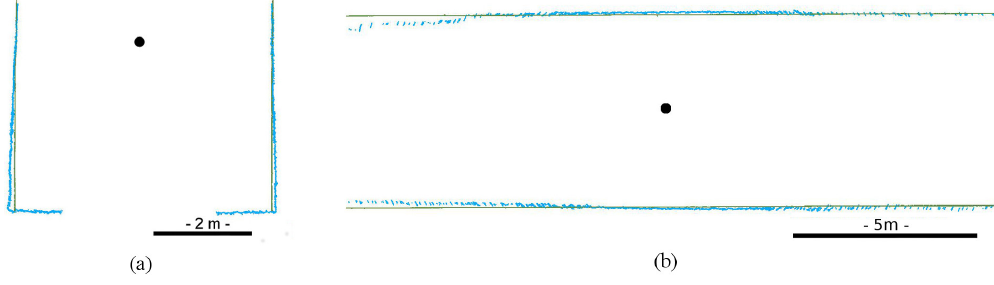
Figure 7. (a) Vertical and (b) horizontal cross-sections of the MSS (blue) and TLS (green) point clouds. Black dots show the sonar head